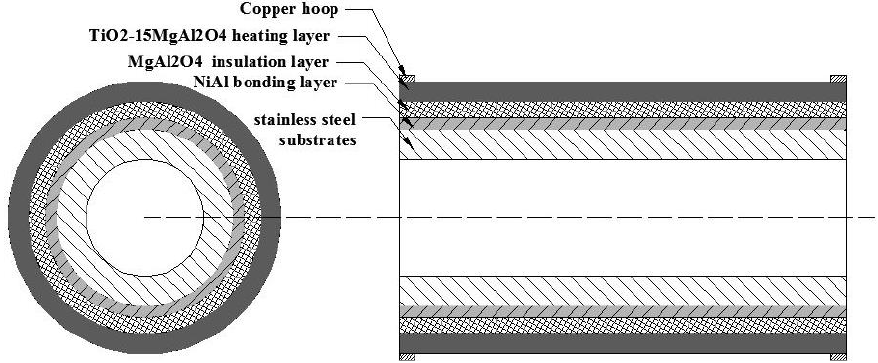
Figure 1. Structure schematic diagram of the coating system sprayed on steel pipe.